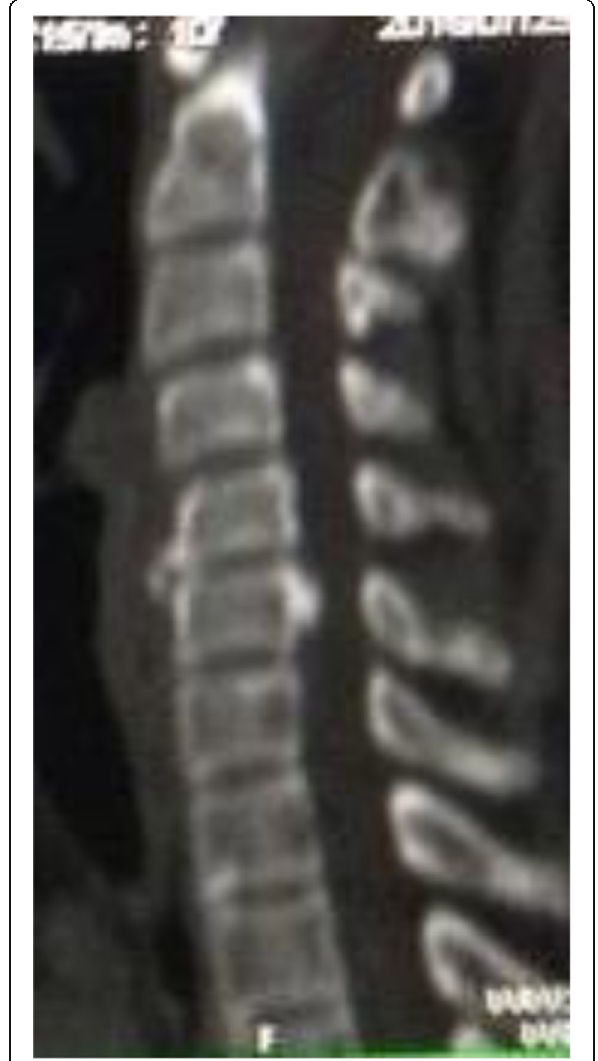
Fig. 7 CT of cervical spine showing focal stenosis due to C6 retro-vertebral